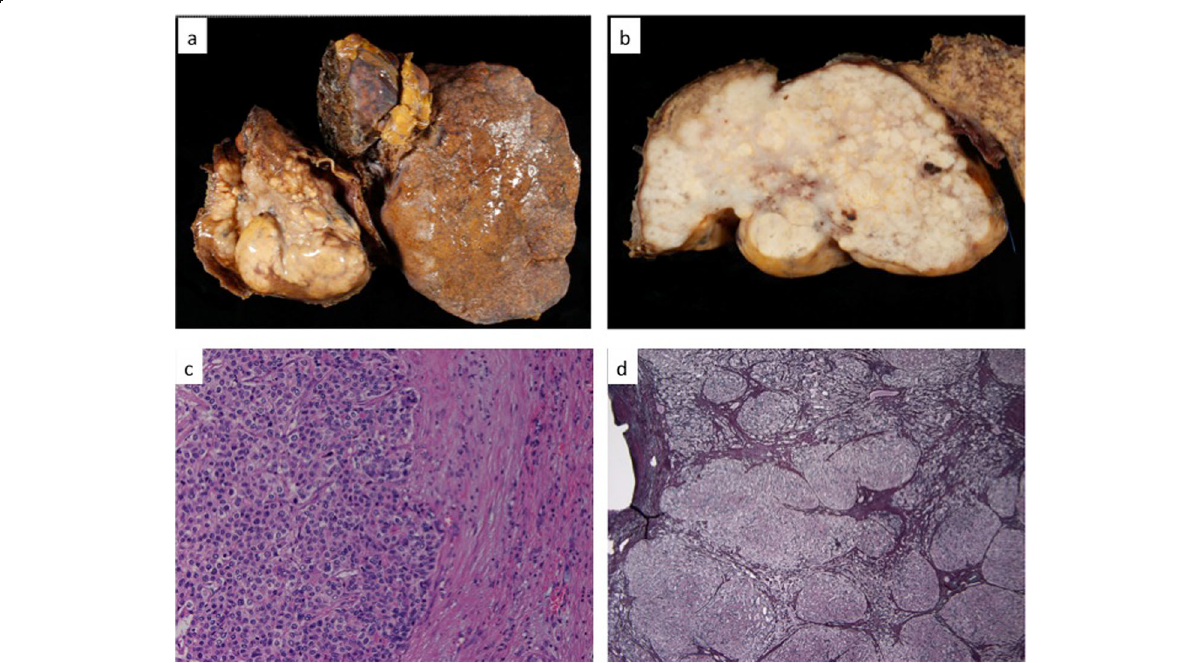
Fig. 4 Macroscopically, this tumor showed 80mm in diameter with white color area with liver cirrhosis ( a , b ). Microscopically, tumor cells showed a poorly differentiated HCC (hematoxylin and eosin staining × 10) ( c ). Noncancerous liver tissue was liver cirrhosis due to congestive liver (silver